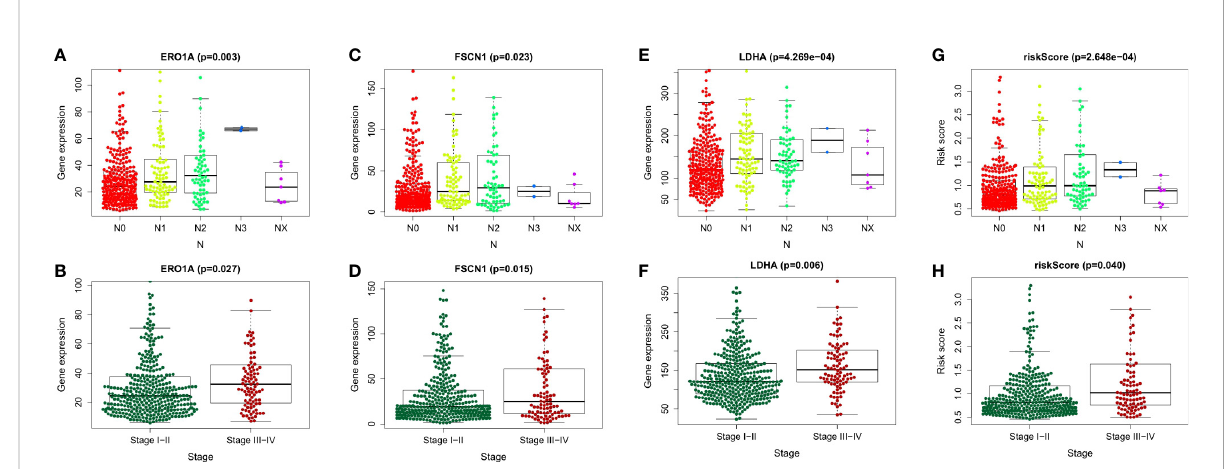
FIGURE 4 Clinical prognostic analysis of the 6 genes and risk score. (A-H) Association of gene expression of ERO1A, FSCN1, LDHA and risk score with tumor stage and Lymph node metastasis in LUAD